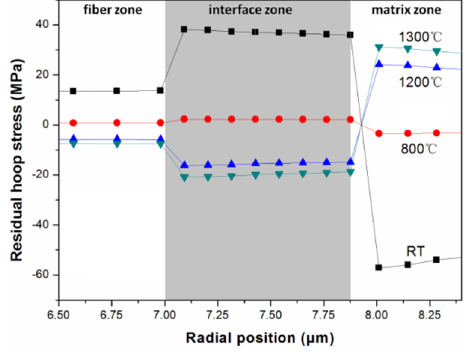
Figure 7. Schematic illustration of influence of interface strength on fracture mode of SiC–SiC.